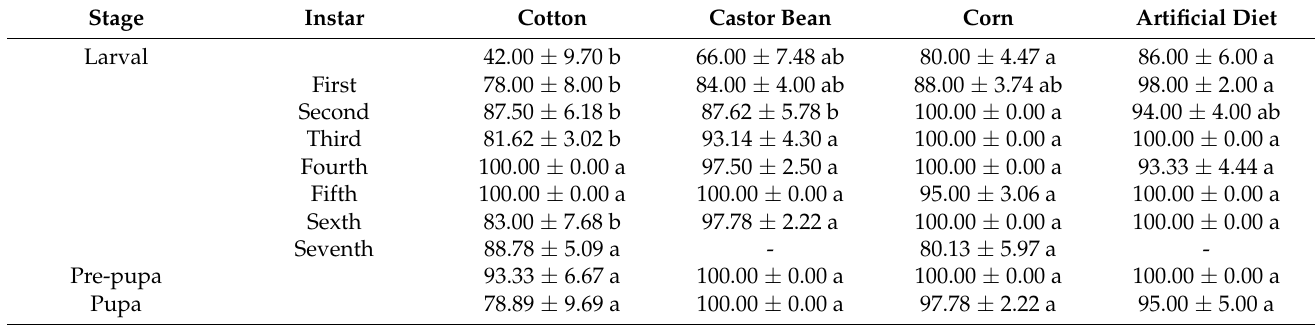
Table 1. Survival (%, mean ± standard error) of the larva stage and of first, second, third, fourth, fifth, sixth and seventh instars, pre-pupa and pupa of Spodoptera frugiperda (Lepidoptera: Noctuidae) fed with pieces of cotton ( Gossypium hirsutum L.), castor bean ( Ricinus communis L.), and corn ( Zea mays L.) leaves an artificial diet at 25 ± 2 ◦ C, relative humidity of 60 ± 10 and photophase of 12